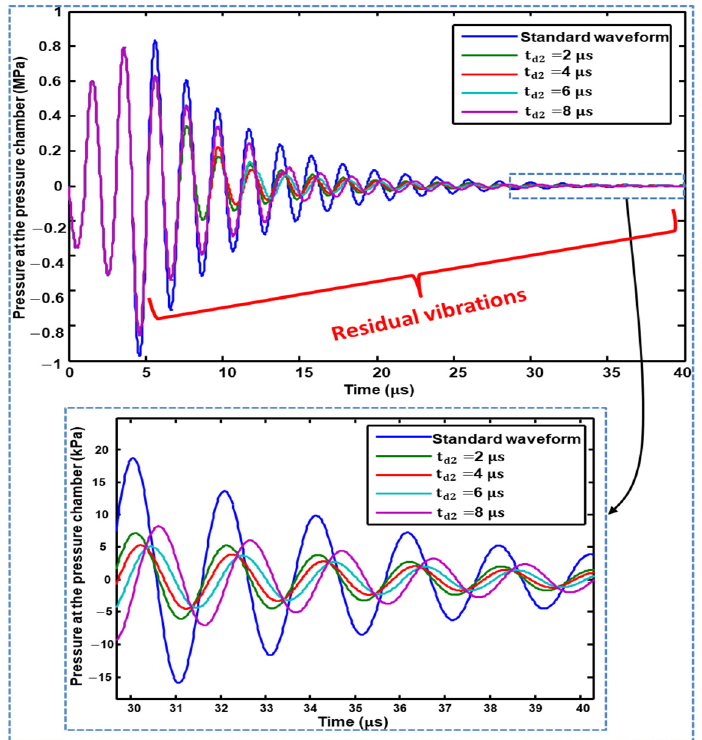
Figure 9. Effect of changing the dwell time of the second pulse of Waveform 02 on residual Figure 9. E ff ect of changing the dwell time of the second pulse of Waveform 02 on residual vibrations.